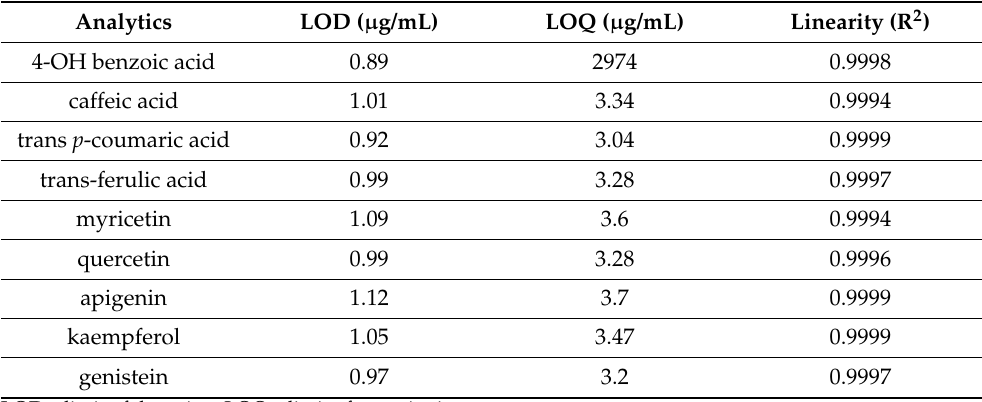
Table 8. The accuracy of the